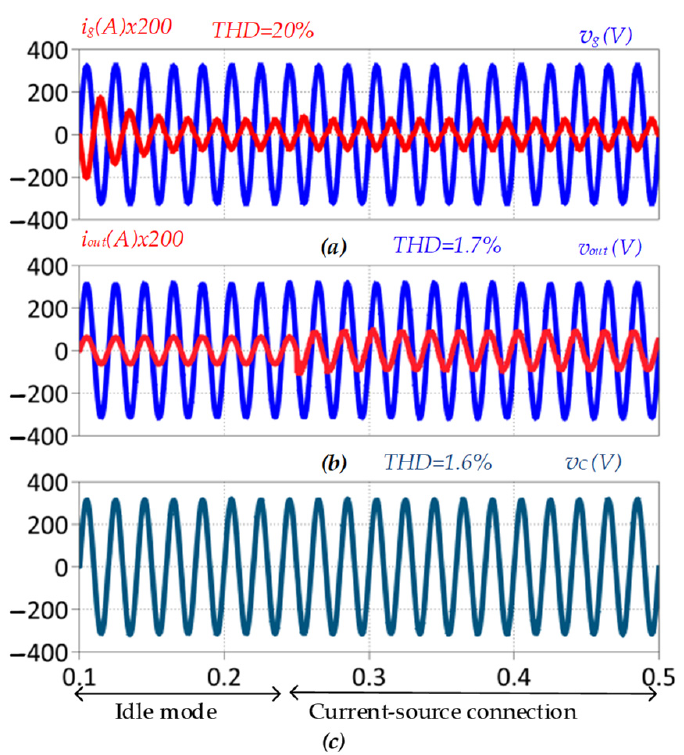
Figure 10. Voltage and current shape transition at the main grid ( a ), output ( b ), capacitor of the filter ( c ) with k out = 0.2, k c = 0.8 in idle mode, and current-source connection.